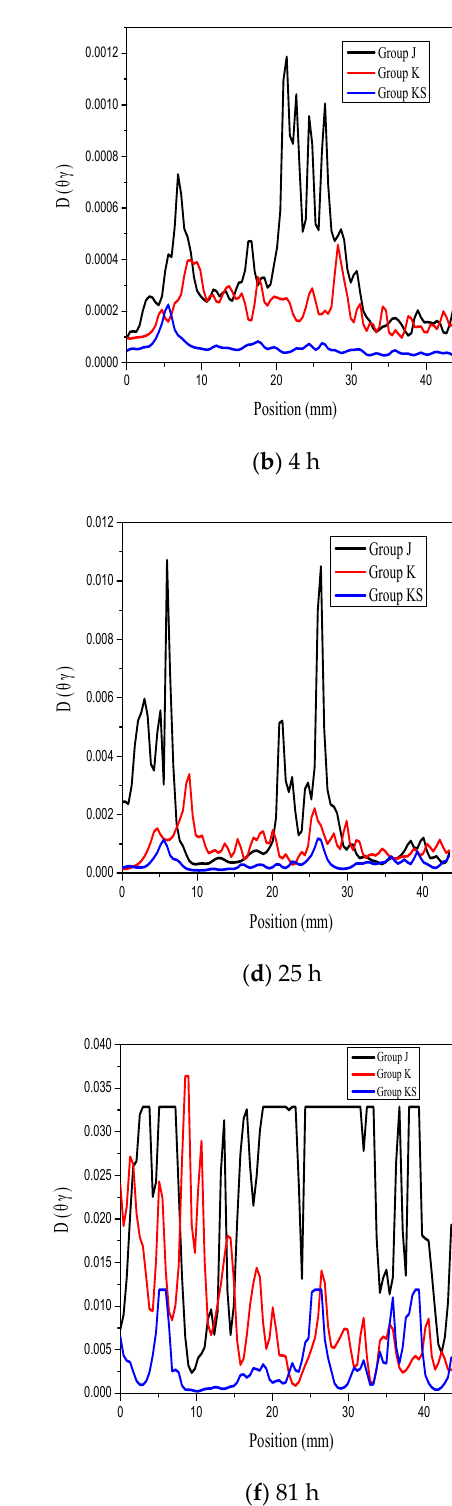
Figure 5. Saturation of water absorption process.